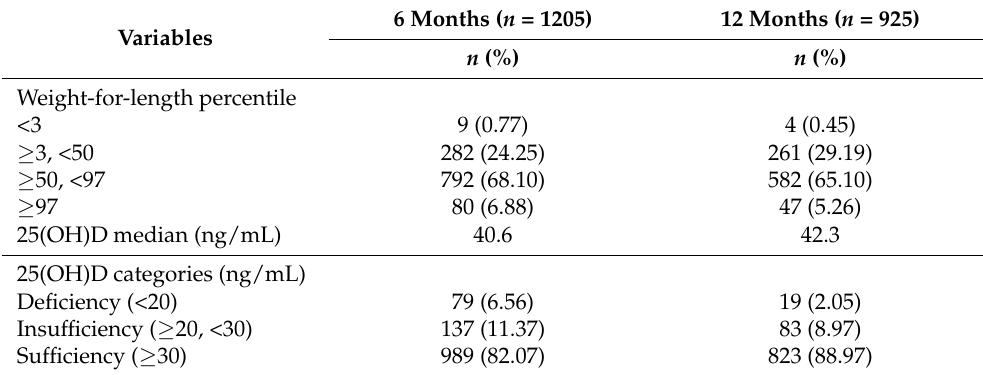
Table 1. Weight-for-length percentile distribution and 25(OH)D status in infants at 6 and 12 months.